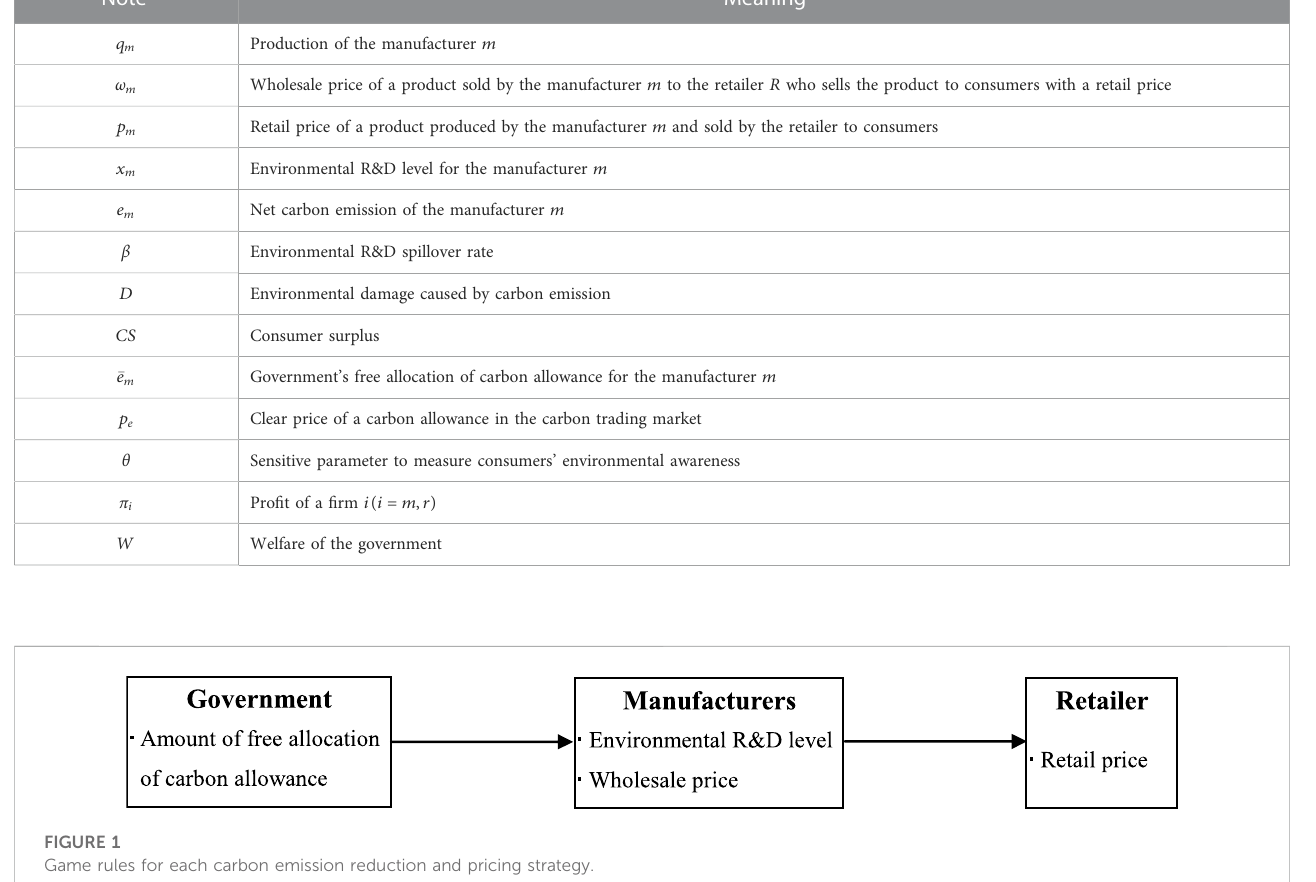
TABLE 1 Meaning of parameters, variables, and functions.